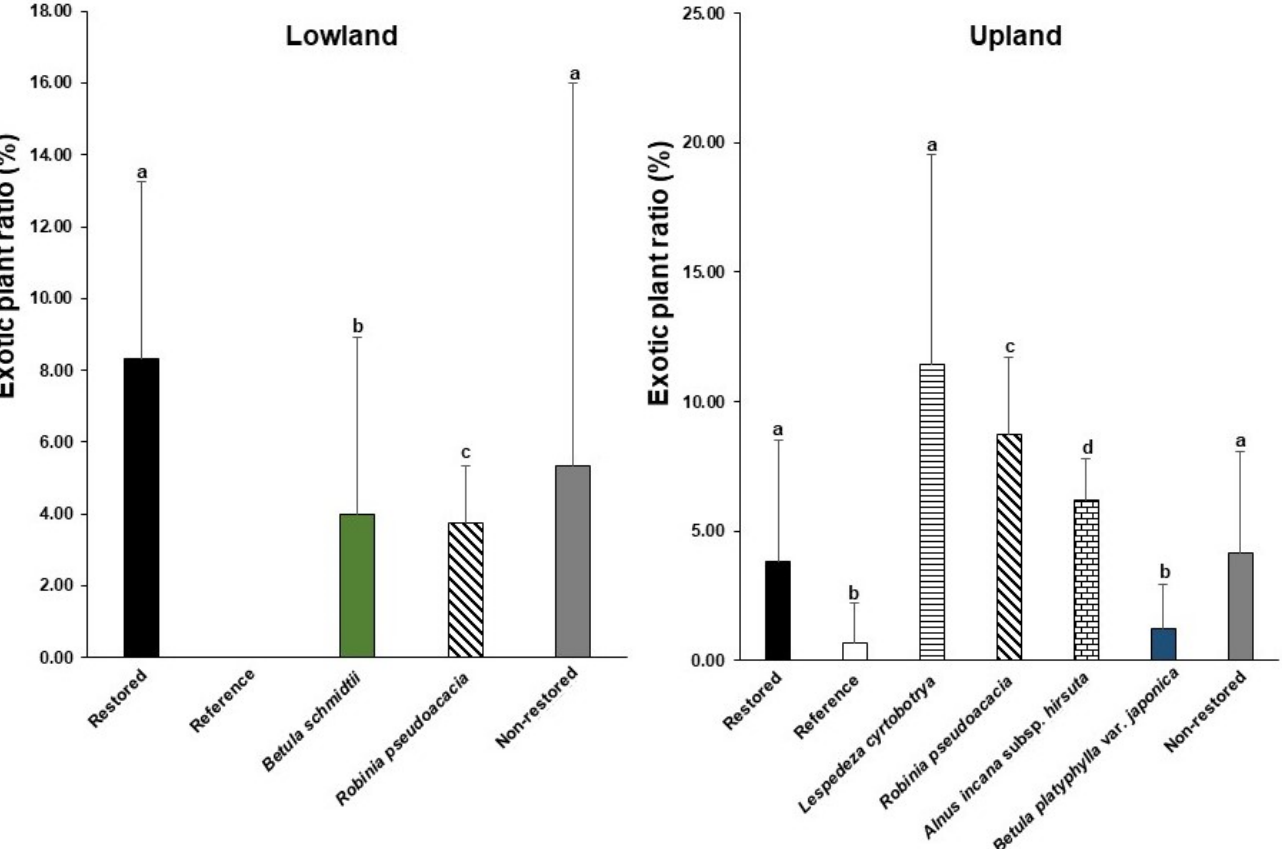
Figure 10. A comparison of the percentage of exotic plants among the treatment sites including the reference site in restoration sites located inn lowland (left) and upland (right) areas, respectively. Each bar expresses the mean and standard error of mean. Tukey’s honestly significant difference (HSD) test was conducted on each of the parameters that showed a statistically significant difference among the three types of treatments at α = 0.05; the means with the same alphabetical character (in superscript) for each parameter were not different from each other.